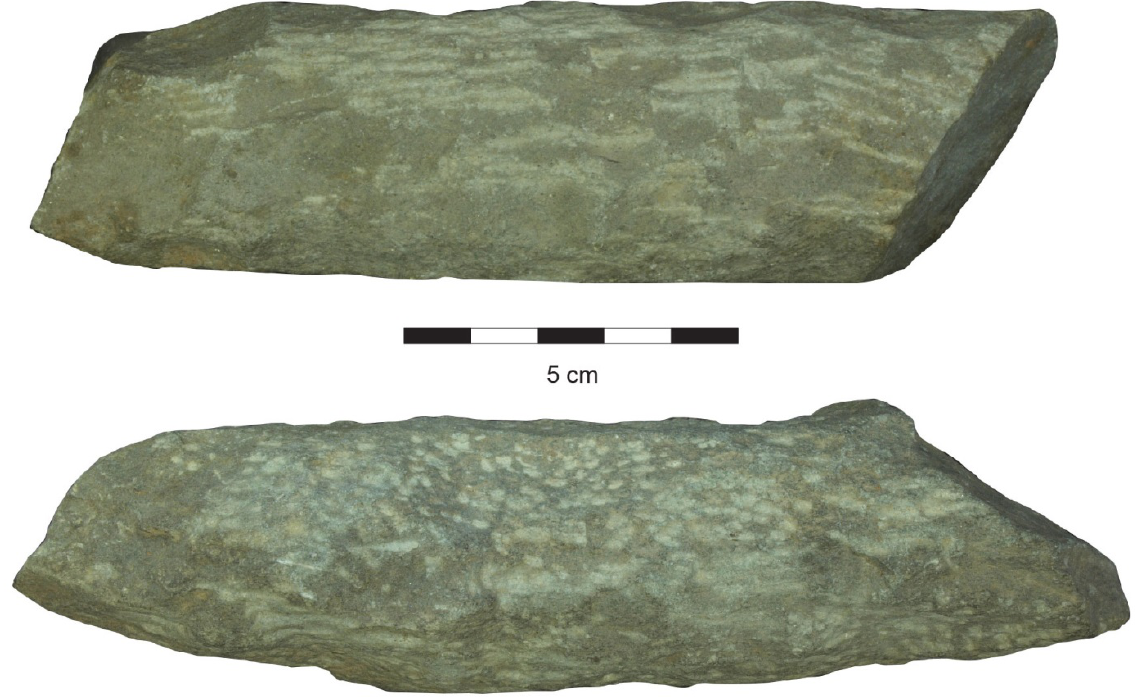
Figure 12: Cylindrical rough-outs with circular cross-section from